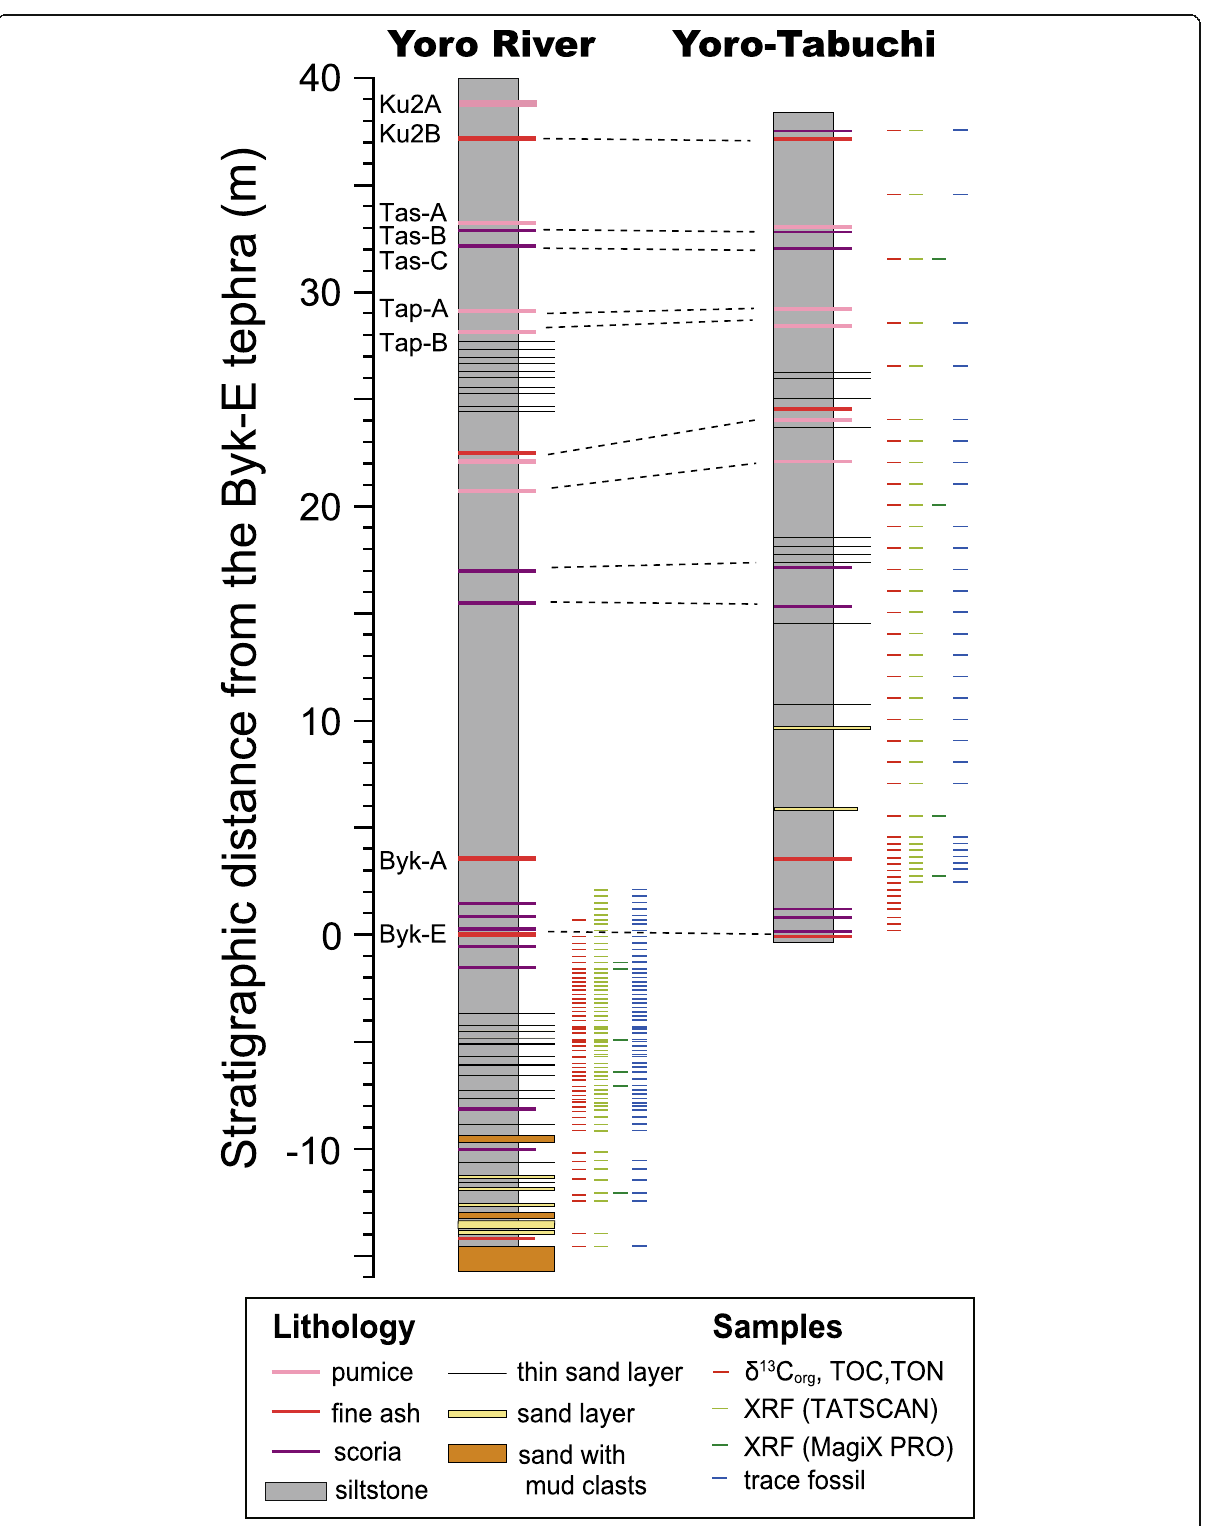
Fig. 3 Lithological logs of the Yoro River and Yoro-Tabuchi sections. The horizons of the samples for geochemical analyses (CN analysis, and XRF analysis) are highlighted. Logs are modified from Suganuma et al. (2018). The Lower-Middle Pleistocene boundary corresponds with the base of the Byk-E tephra (at 0 m in the lithological